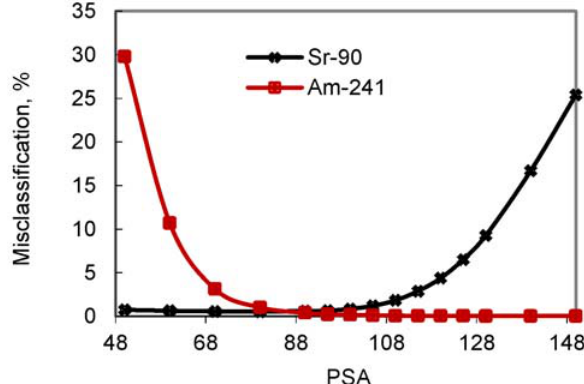
Figure 4. The graphic of the optimum PSA level determination for plastic vial in UG AB cocktail